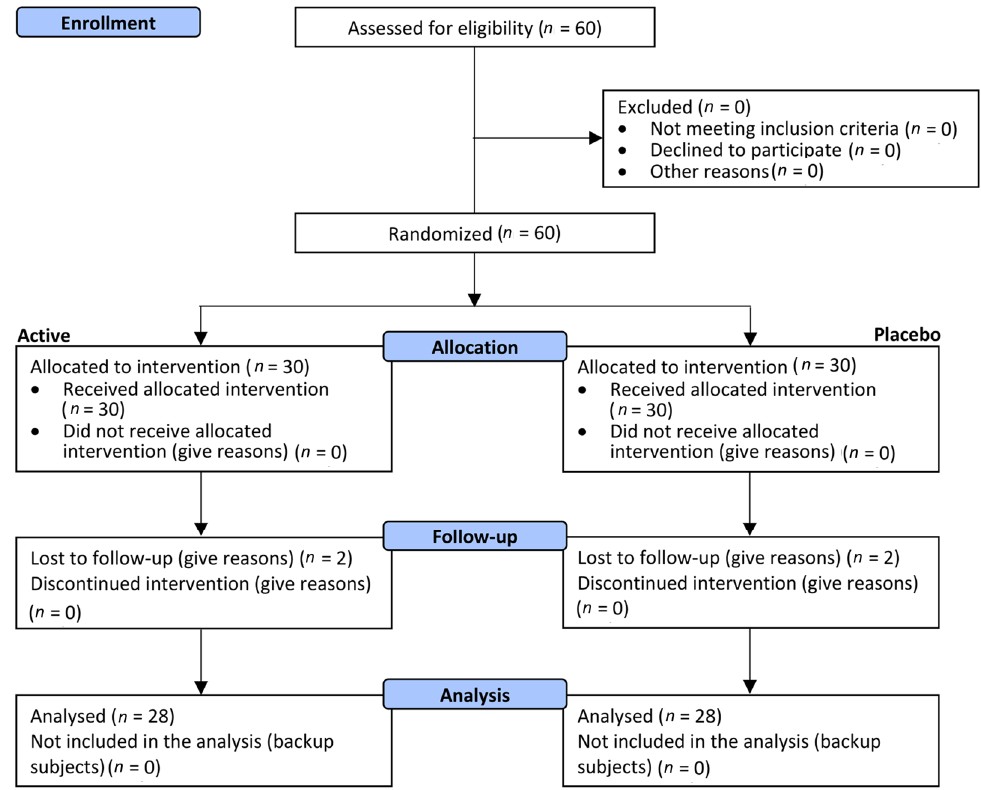
Figure 1. Participants flow diagram.